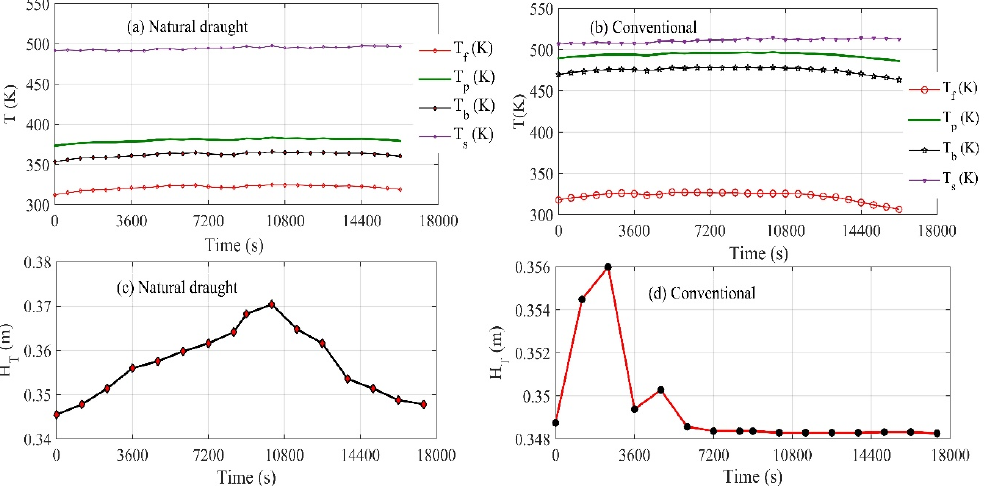
Figure 8. Temperature distribution and total pressure head at the outlet (( a ) temperature distribution for a unit equipped with natural draught system, ( b ) temperature distribution for the conventional unit, ( c ) total pressure head for a unit equipped with natural draught system, ( d ) total pressure head for a unit equipped with the conventional unit).